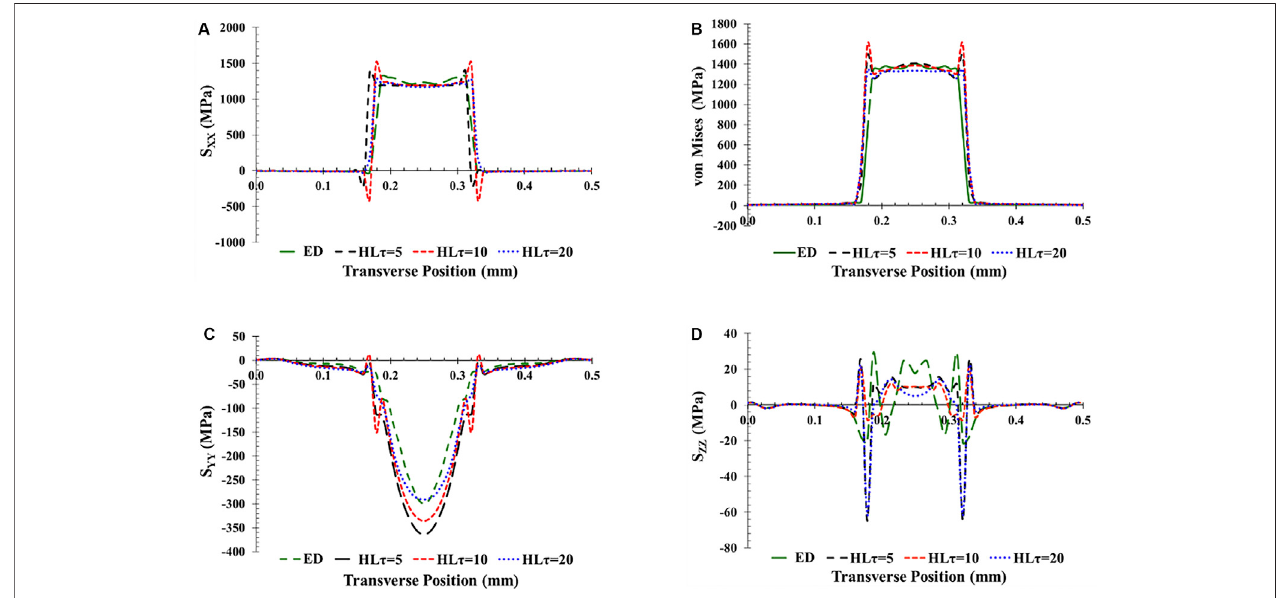
FIGURE 8 | Single-track residual stress distributions along line 2 in Figure 2 for ED and HL models. (A) von Mises (B) S XX (C) S YY (D) S ZZ stresses.